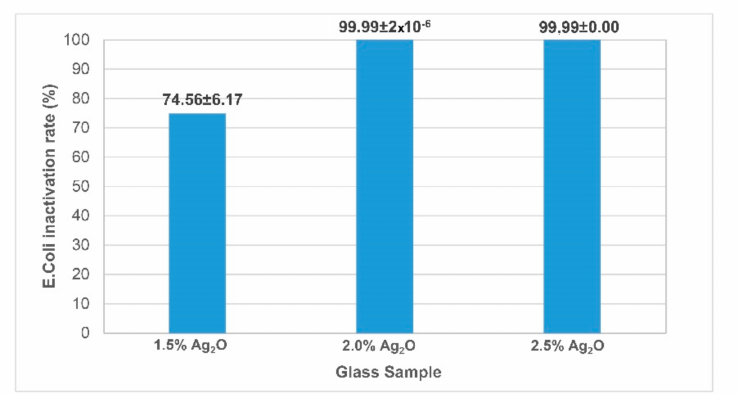
Figure 3. Inactivation rate of Escherichia coli